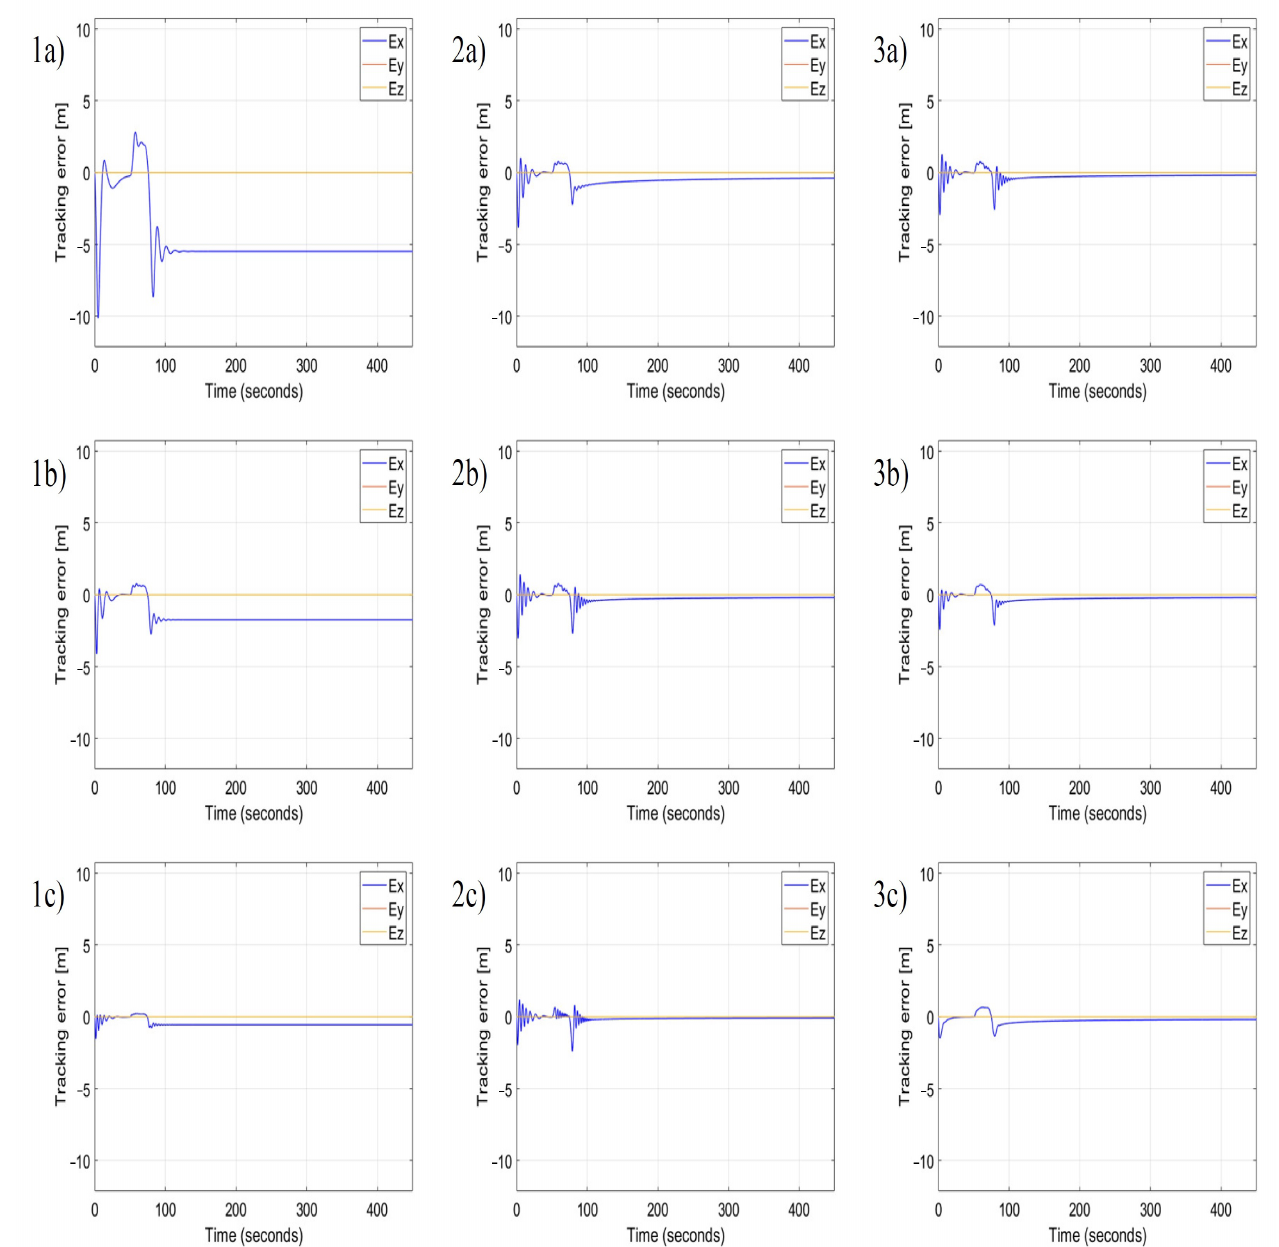
Figure 10. Time plots of position tracking errors for different coefficients α , β , δ Ix 1 , δ Ix 2 , δ Dx 1 and δ Dx 2 for the nonlinear P, PI, and PID controllers in the case of longitudinal wind gusts. Applied values of coefficients are given in Table